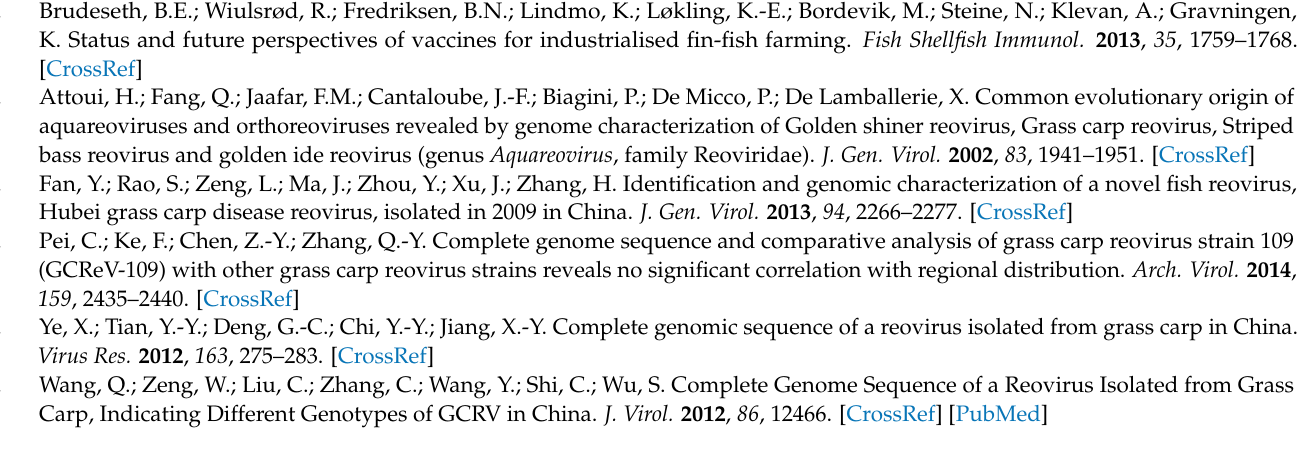
Table S1: Primer sequences in this study, Table S2: Feed formulation, Table S3: Statistical results of histological lesions in spleen and trunk kidney of grass carp on day 7 post-GCRV II infection, Table S4: Mortality rate and RPS of grass carp